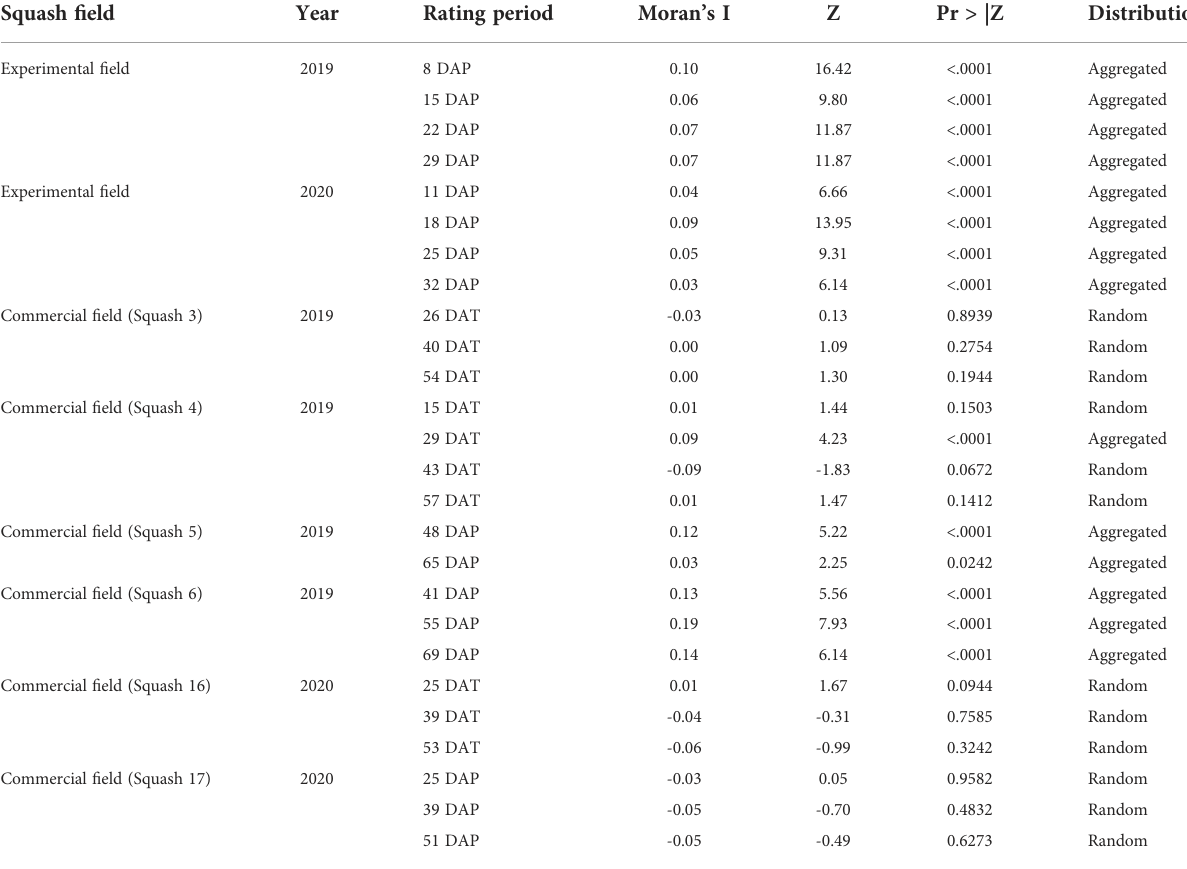
TABLE 6 Two-dimensional spatial distribution of adult white fl ies based on leaf- fl ip counts in yellow squash fi elds based on spatial autocorrelation analysis per fi eld and per rating period. Squash fi